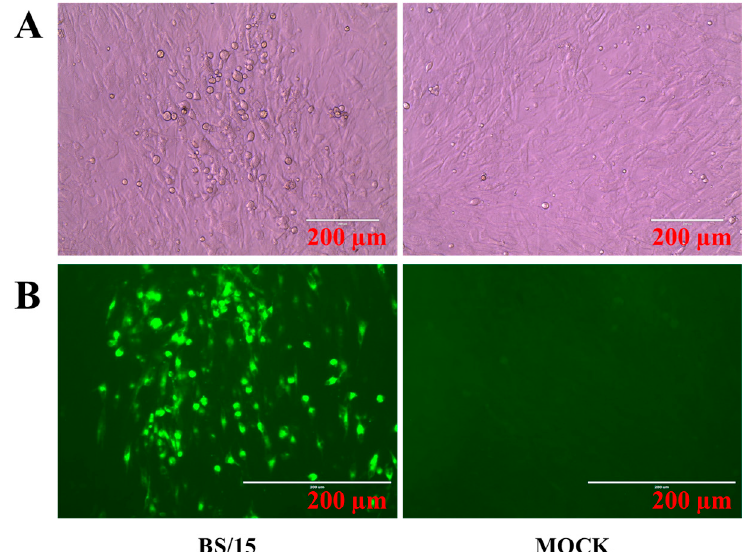
Figure 2. Viral plaques of CEF cultures caused by MDV infection, and immunofluorescence assays (IFAs). ( A ) Viral plaques of CEF cultures caused by MDV BS/15 were evident by light microscopy at 120 h post ‐ inoculation; ( B ) Specific staining of the viral plaques with an MDV gI ‐ specific monoclonal antibody was observed by fluorescence microscopy. Scale bar: 200 μ m.